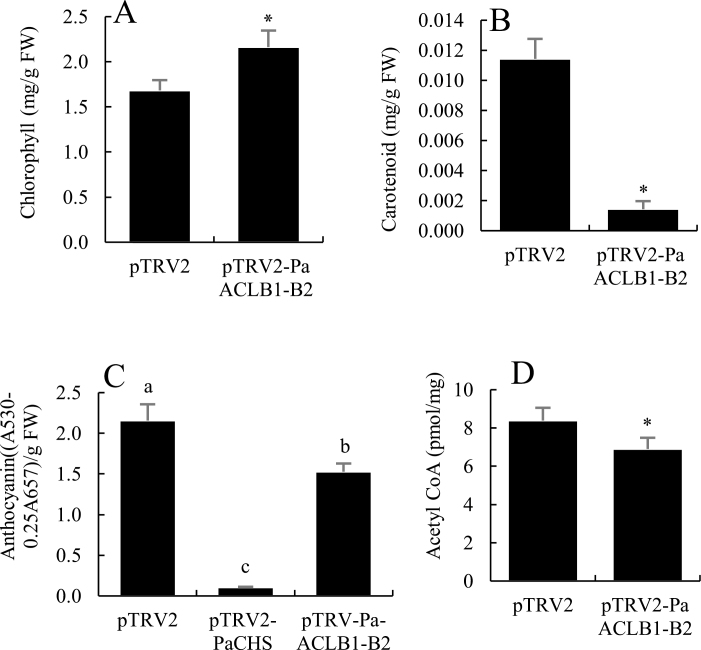
Effects of PaACLB1-B2 silencing on the chlorophyll, carotenoid, anthocyanin, and acetyl-CoA content in petunia. (A) Chlorophyll and (B) carotenoid content in leaves. (C) Anthocyanin content in corollas. (D) Acetyl-CoA content in corollas. Data are presented as means ±SD (n=3). *P≤0.05.